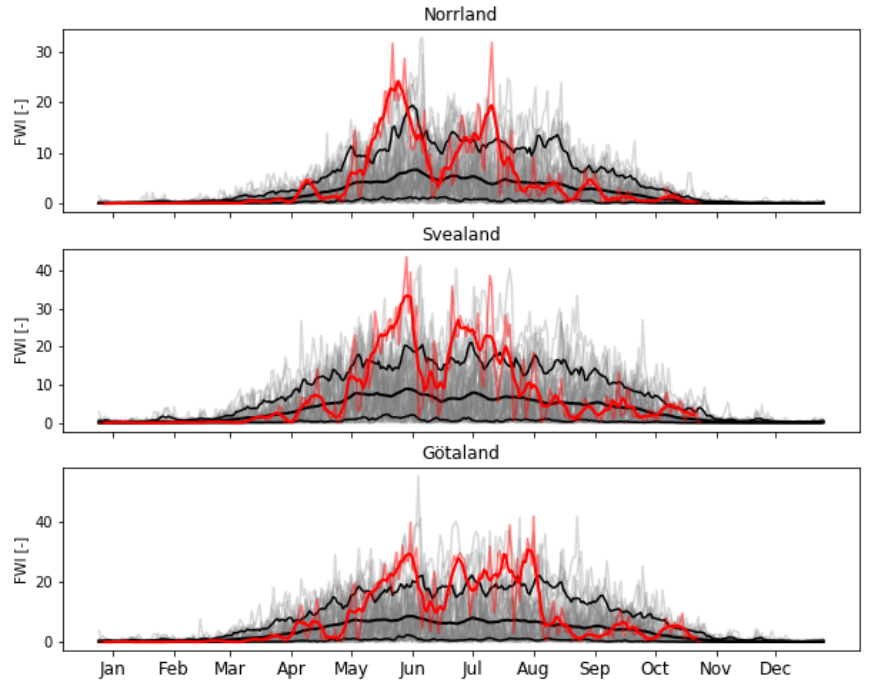
Figure 5. Area-averaged FWI for the three regions (defined in Fig. 3). The (thick) red line shows the (7d running mean) FWI of 2018. The black lines represent the 5%, 50% and 95% quantiles of the 1979–2017 climatology, and the opaque grey lines represent the individual years, all based on ERA-Interim data extended with ECMWF forecast